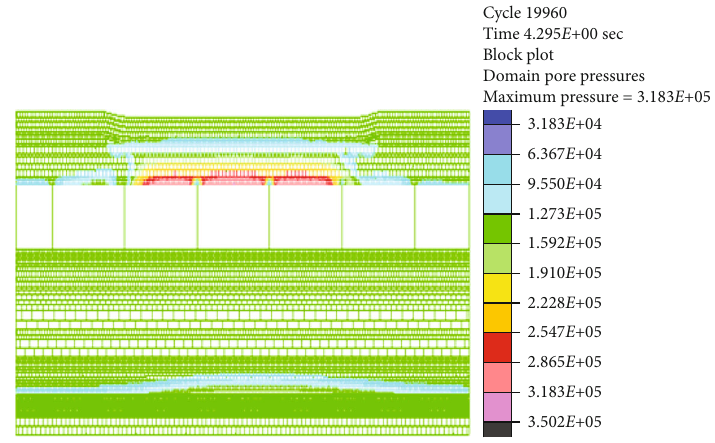
Figure 2: The water pressure distribution in initial equilibrium.